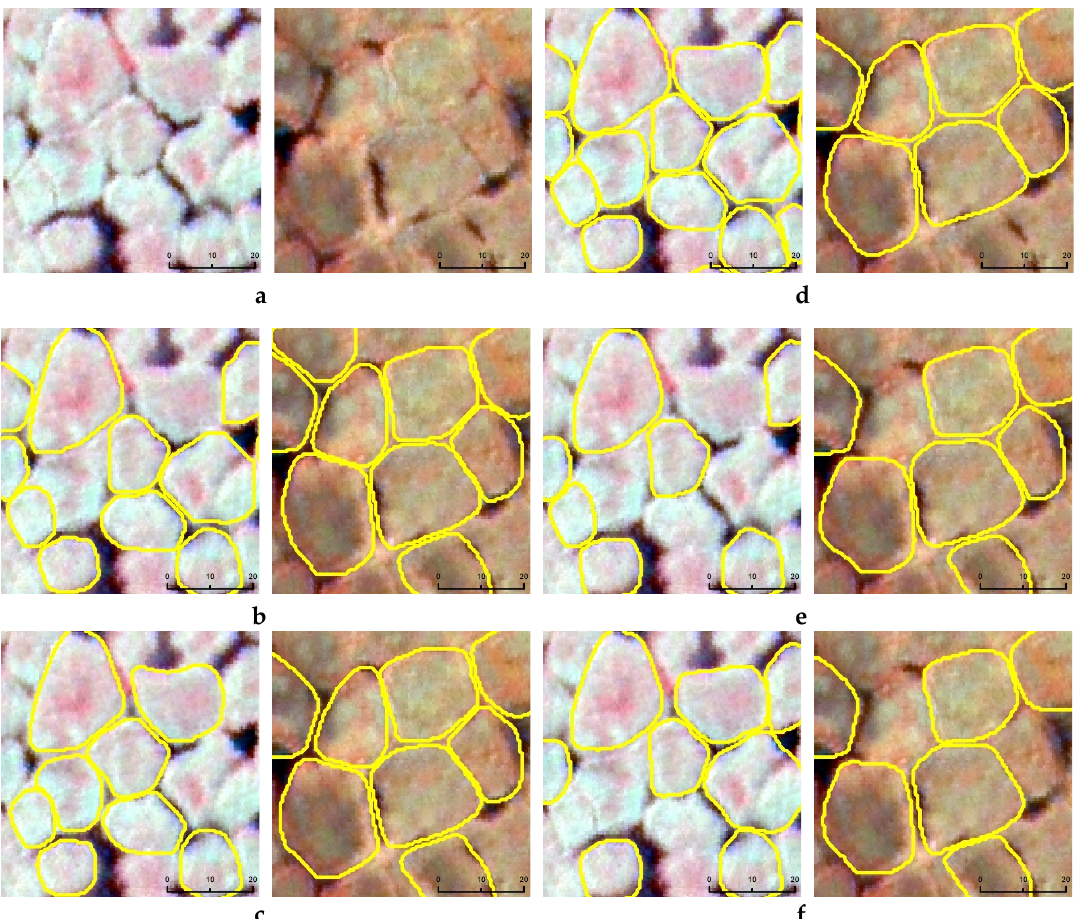
Figure 7. Simplified zoomed-in views of original imagery and model predictions. ( a ) original imagery for non-tussock sedge (form left column 1) and original imagery for tussock sedge (from left column 2); band combination ( b ) (1,2,3); ( c ) (2,3,5); ( d ) (2,3,7); ( e ) (3,4,5); ( f ) (3,5,7). Yellow outlines denote automatically detected IWPs. Imagery © [2012,2015] DigitalGlobe, Inc. (Westminster, CO, USA). Table 3. Accuracy assessment of detection for candidate image scenes.